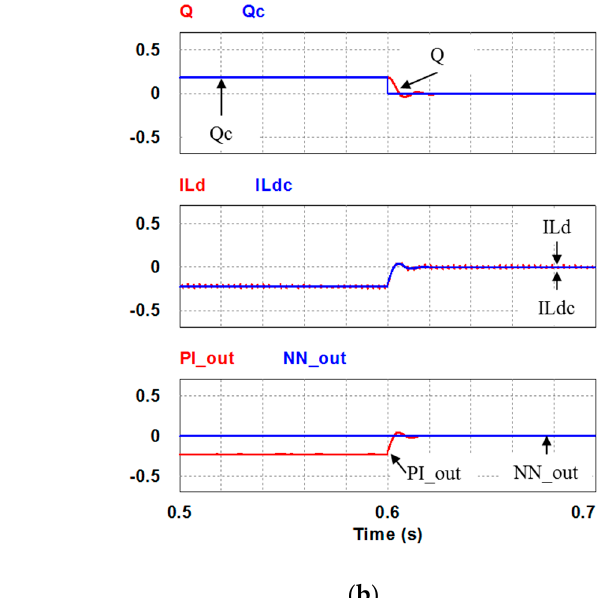
( b ) Figure 19. Detailed views of Figure 18: ( a ) from 0.3 to 0.5 s; ( b ) from 0.5 to 0.7 s.